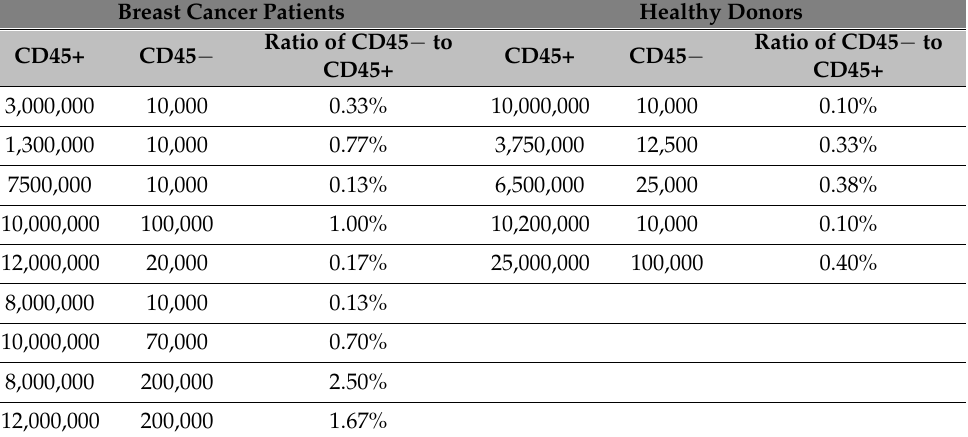
Table A1. Count of CD45+ and CD45 − cells per sample in absolute numbers. This table also in- cludes samples that were not used in OS experiments since the cell count was too low for an OS measurement. 10,000 cells is the lower resolution limit of the cell counter we used and therefore appears whenever the total count is 10,000 cells or lower.